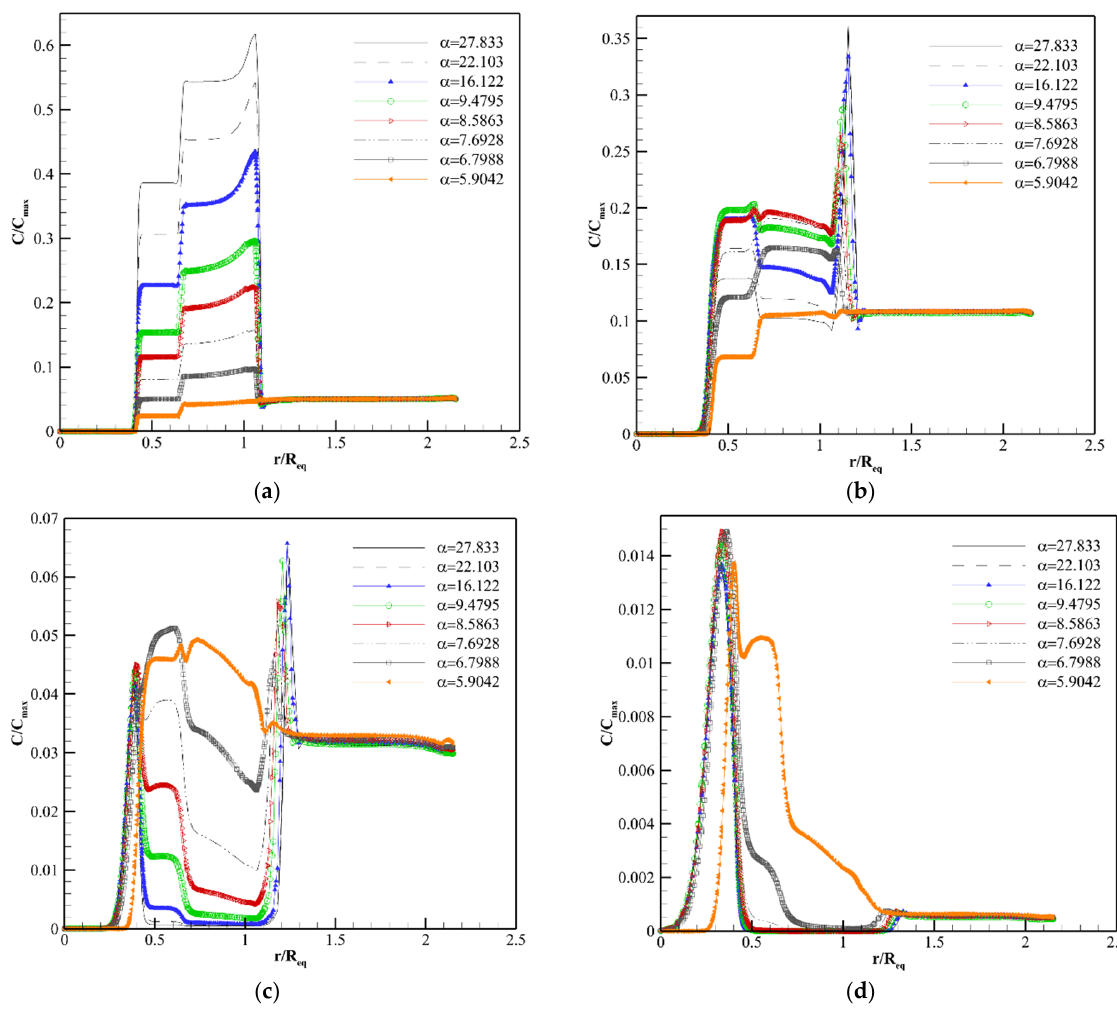
Figure 9. Distribution of ( ) F ab ′ concentration along line 1. ( a ) 1 h post-injection. ( b ) 8 h post-injection. ( c ) 24 h post-injection. ( d ) 72 h post-injection.